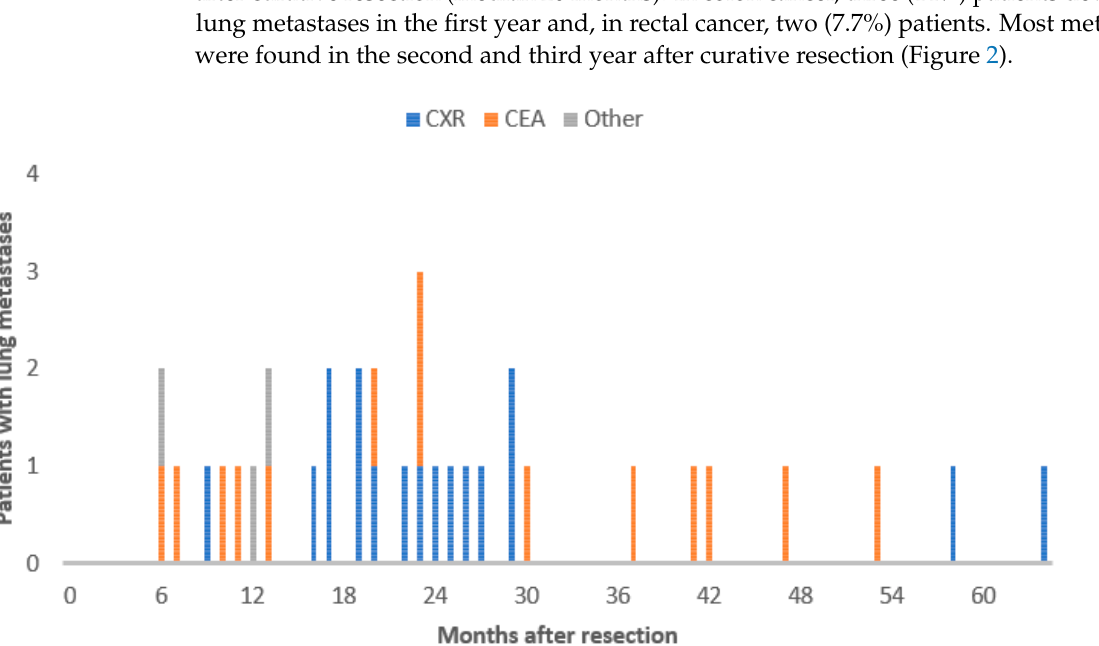
Within the group of patients with lung metastases, 21 patients had colon cancer (5% of all colon cancer patients) and 13 patients had rectal cancer (7% of all rectal cancer patients). The timing of the development of lung metastases varied greatly, between 6 and 63 months after curative resection (median 20 months). In colon cancer, three (14%) patients developed lung metastases in the first year and, in rectal cancer, two (7.7%) patients. Most metastases were found in the second and third year after curative resection (Figure 2). Figure 2. Timing of development of lung metastases found with different surveillance tests. Fifteen out of thirty-four (44%) patients with lung metastases were treated with curative intent (Figures 2 and 3). Patients with lung metastases found by an abnormal CXR had significantly higher chance of curative treatment than patients with increased levels of CEA (65% vs. 21%, p = 0.049, Figure 3). Out of 14 patients with lung metastases and elevated serum CEA levels, 6 patients had lung metastases solely. Of these patients, three were treated with curative intent. Out of 17 patients with lung metastases, found with an abnormal chest X-ray only, 12 had lung metastases solely (Table 1). Ten out of these patients were treated with curative intent. In the group of nine patients with lung metastases and normal CXRs, three patients were treated with curative intent (Figure 1). With an average of 37 months after finding the lung metastases, 13 (86.7%) of the curatively treated patients are still alive (Figure 3), 5 without recurrences. The median survival of patients with metastatic disease was 66% (95%CI = 39–71%) for normal CEA versus 48% (95%CI = 36–60%) for increased CEA levels. Although the hazard suggests improved chance of survival in normal CEA metastatic disease, this was not statistically significant (P logrank = 0.33 and Hazard Ratio (HR)=0.63; 95%CI = 0.24–1.63; p = 0.340).